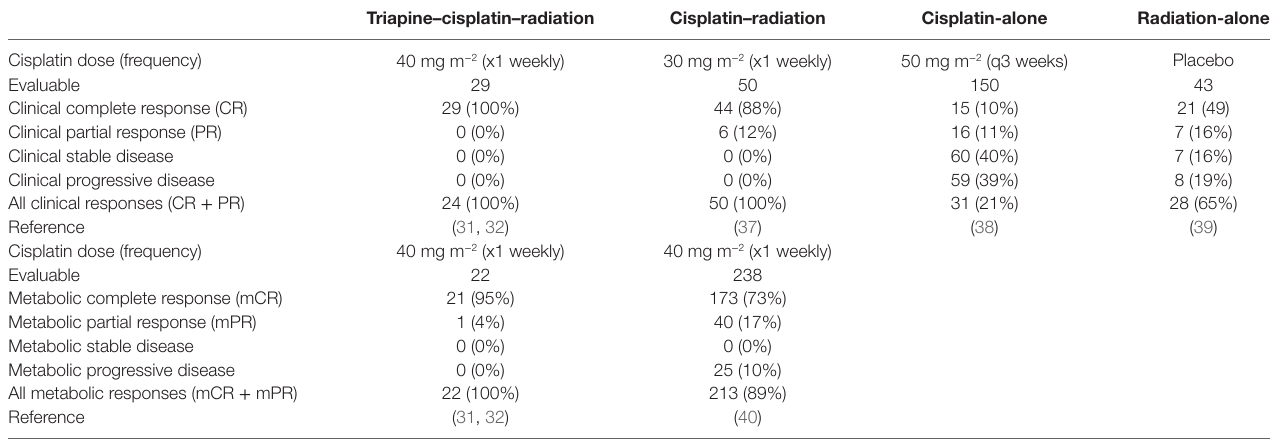
tAble 2 | Responses a of cervical tumor to indicated